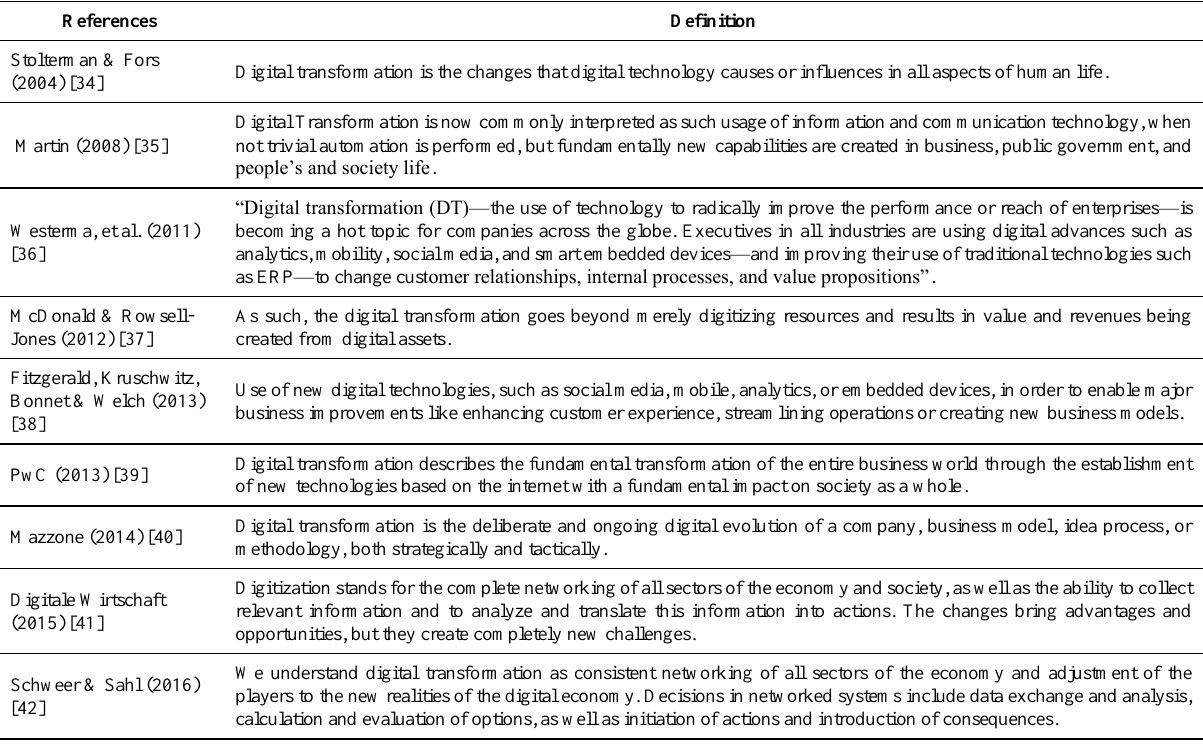
Table 1. Definitions related to digital transformation terms [32,